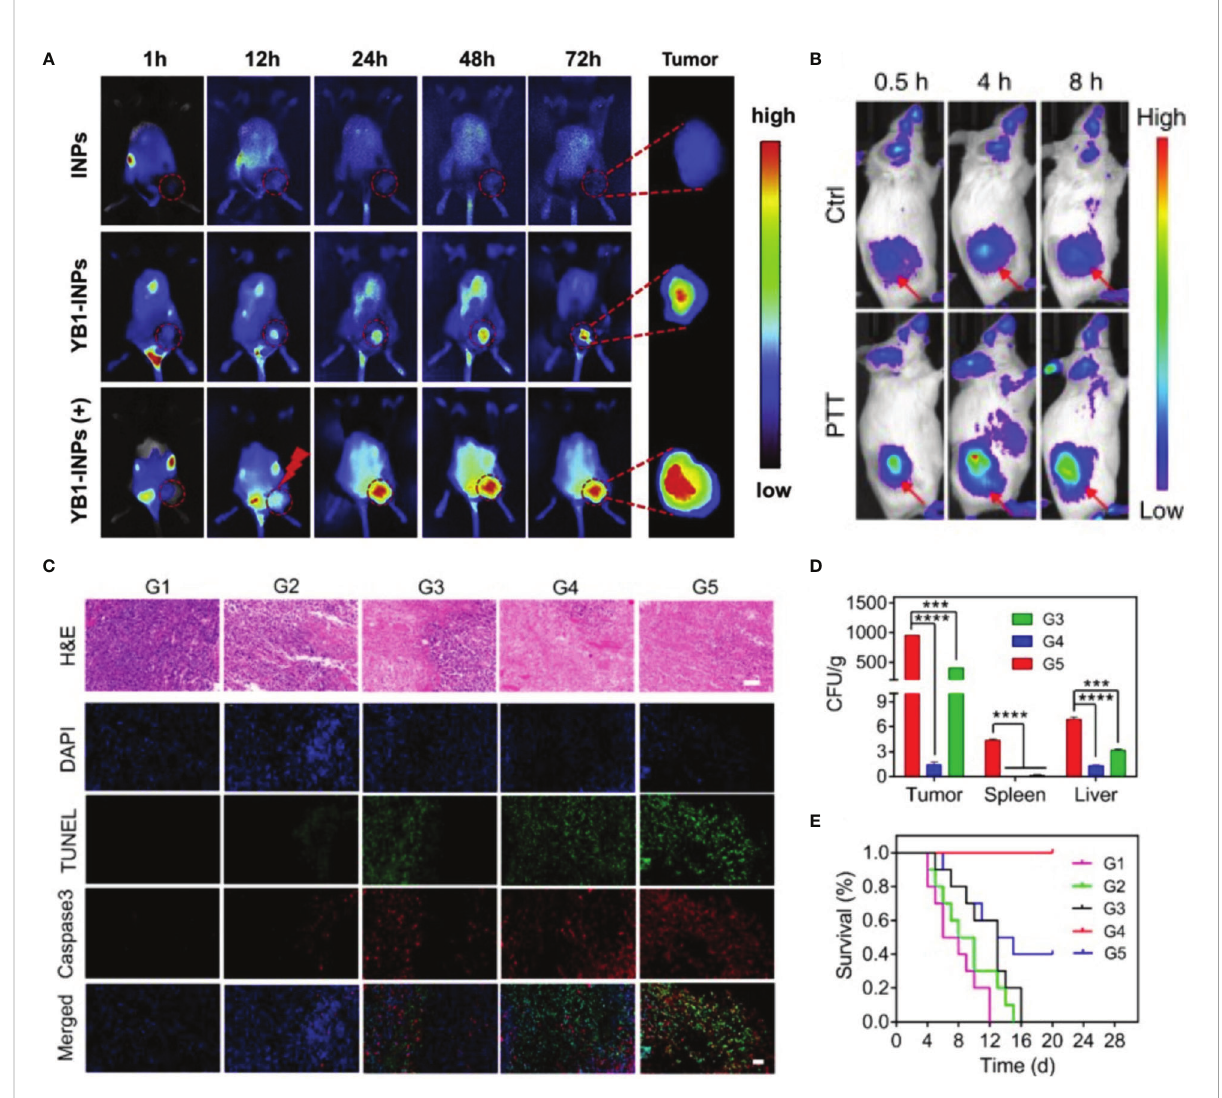
FIGURE 2 Bacteria-mediated nanoparticles have ef fi cient imaging properties and superior therapeutic outcome. (A) In vivo FL imaging of YB1-INPs, (+) refers to laser irradiation at 12 h. Reprinted with permission (46). Copyright 2019 Biomaterials. (B) In vivo FL imaging of OMV-labeled SP-AgNPs. Reprinted with permission (48). Copyright 2020 Nature Communications. (C-E) Therapeutic ef fi cacy and safety evaluation of OMV-NPNs@Pt. Reprinted with permission (47). Copyright 2021 Nano Letters. (C) H&E, TUNEL, and Caspase 3 staining of tumor sections after